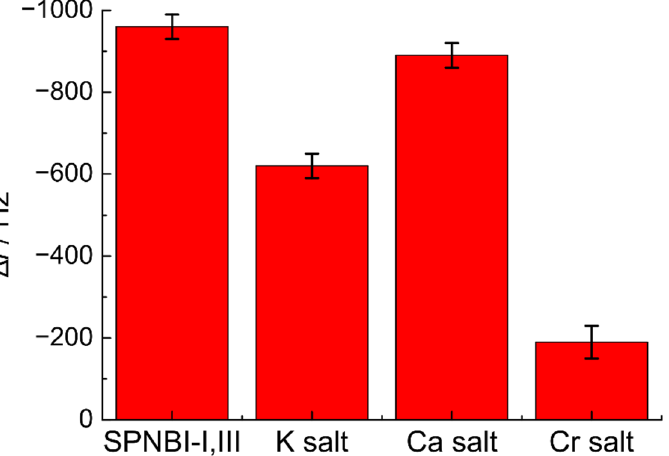
Figure 5. The oscillation frequency difference ( Δ f = f APAP — f water ) between QCM sensors coated by SPNBI-I,III and its K, Ca, and Cr salts immersed in acetaminophen solution ( f APAP ) and in distilled water ( f water ).